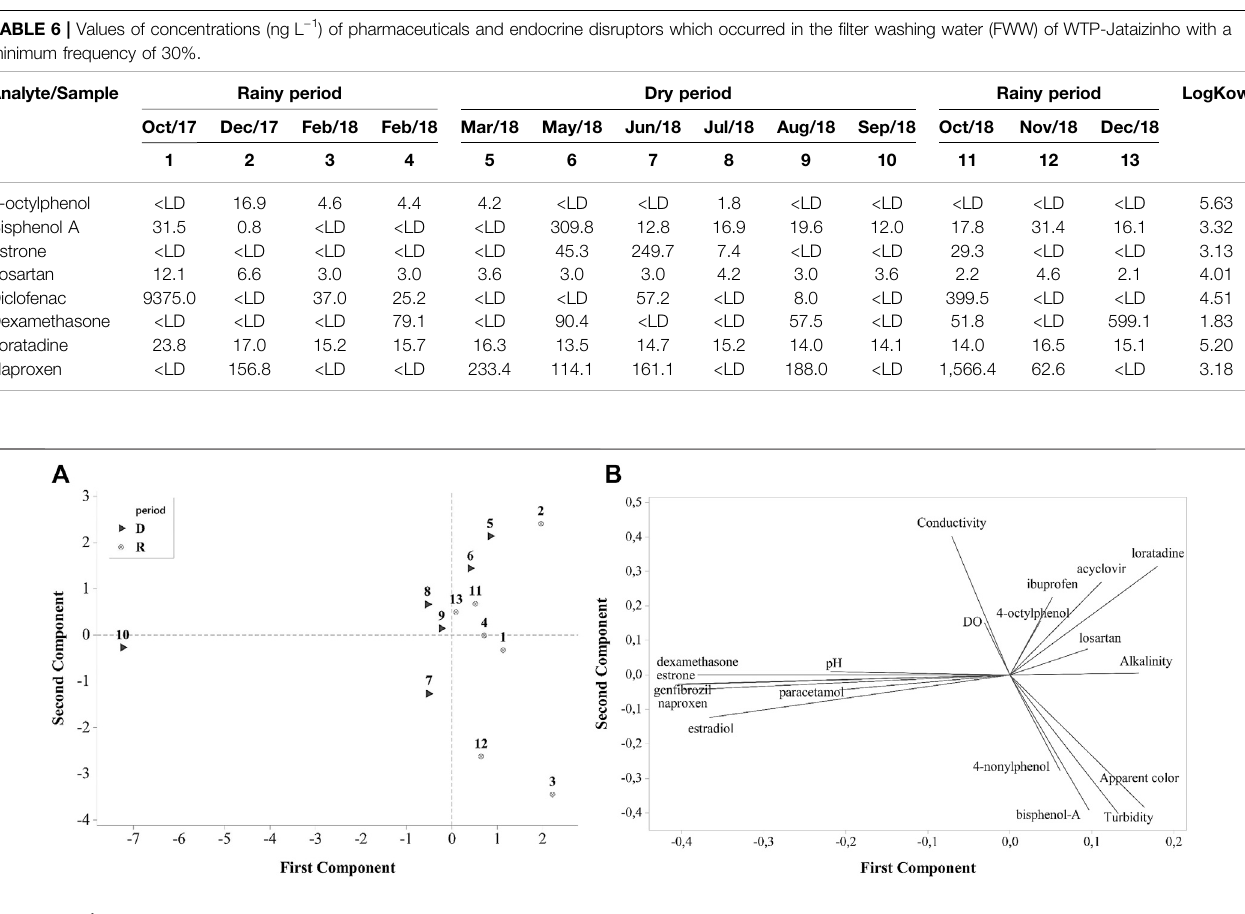
Frontiers in Environmental Science |